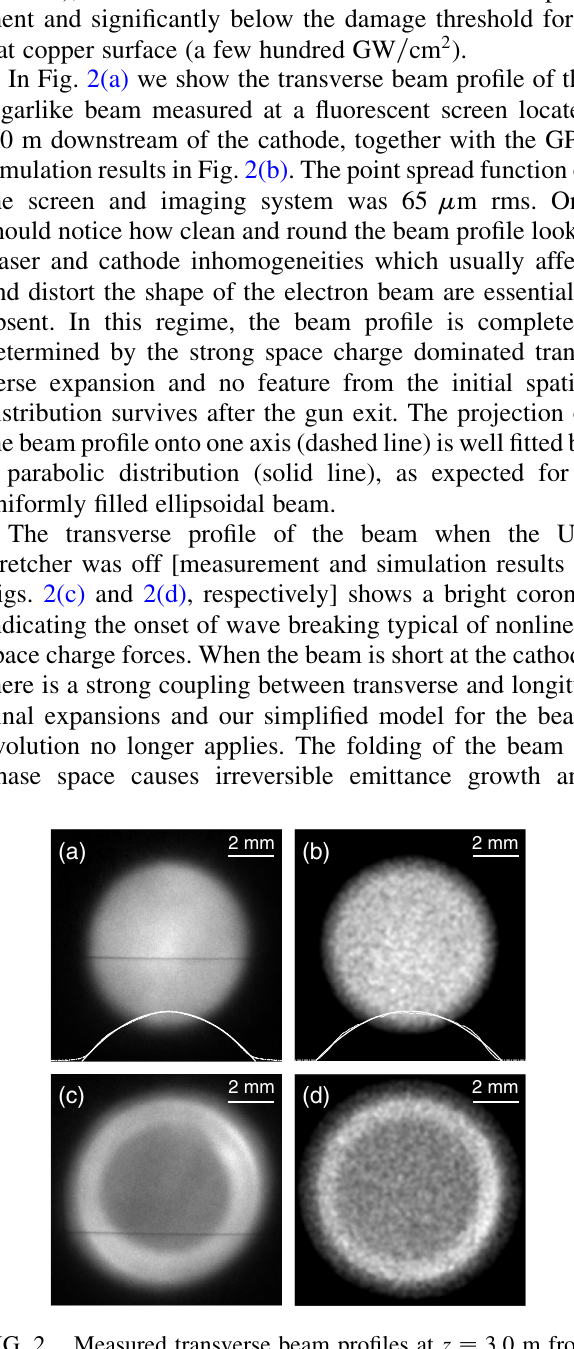
of the beam x on the f